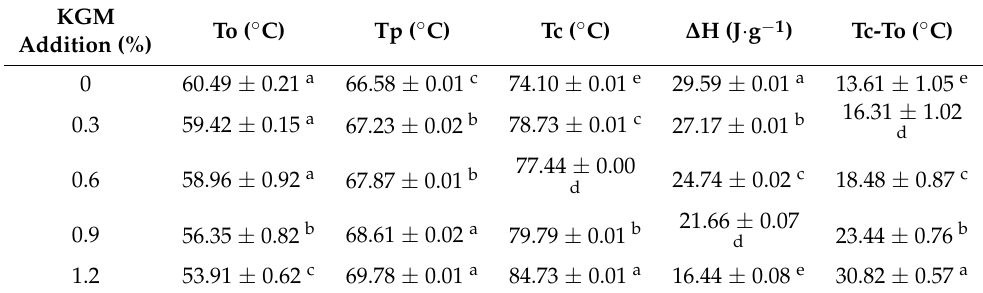
Table 4. Thermal parameters of CS/KGM